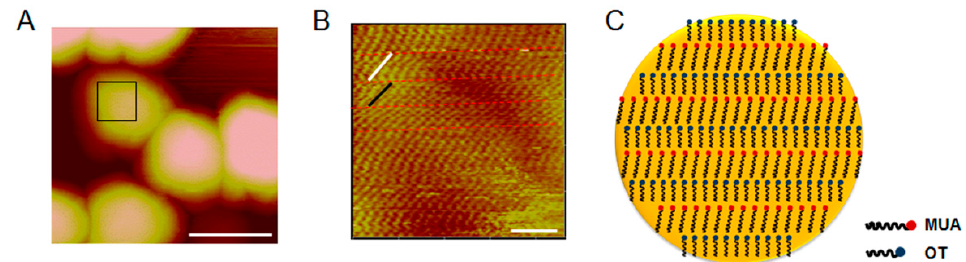
Figure 8. Surface characterization of 50% MUA GNPs by atomic force microscopy (AFM). ( A ) AFM image of 50% 11-mercaptoundecanoic acid (MUA) GNPs. Diameter is ~15 nm. Size of image is 63.88 nm × 63.88 nm. ( B ) AFM image of surface of 50% MUA GNPs. Molecules on surface show regular arrangement with zonal distribution. Size of image is 9.235 nm × 9.235 nm. ( C ) Schematic of the 50% MUA GNP surface pattern.